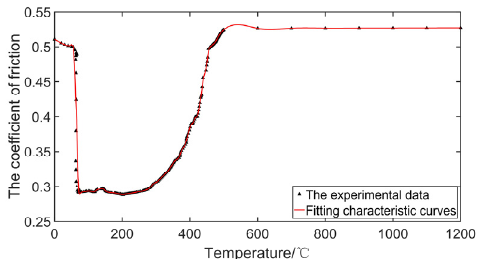
Figure 4. Variation curve of the friction coefficient of the C/SiC brake disc with temperature.